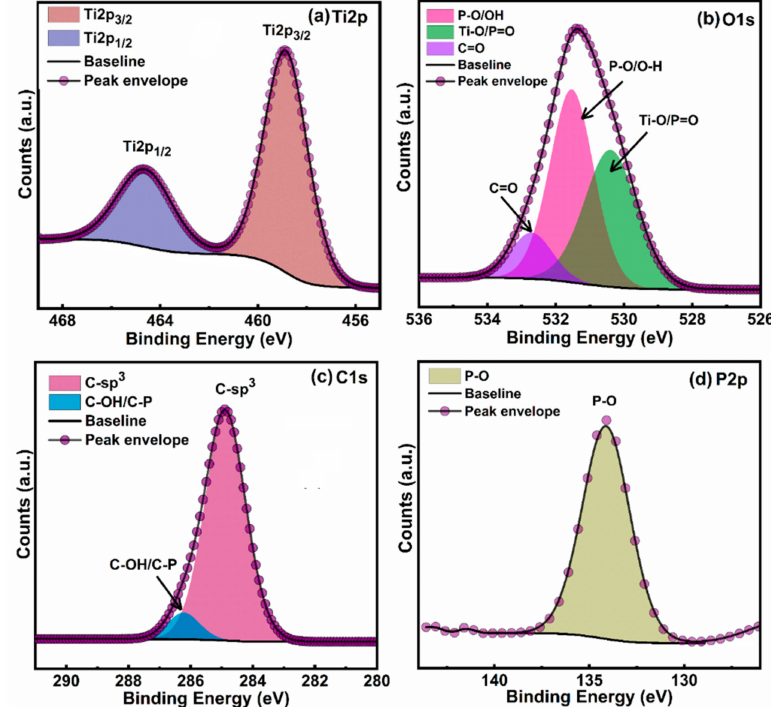
Figure 5. Core-level HR-XPS spectra of ODPA functionalized TiO 2 nanotubes in ( a ) Ti2p region; ( b ) O1s region; ( c ) C1s region; and ( d ) O1s